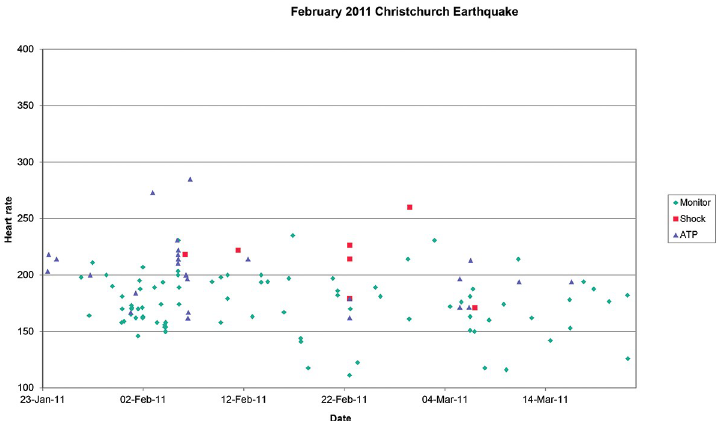
Fig 2. Ventricular arrhythmia events recorded by implantable defibrillators in 236 patients exposed to the earthquake on the 22nd February 2011. Events are plotted against event heart rate. Events are classified as non- sustained (monitor), sustained treated by shock and sustained treated by antitachycardia pacing (ATP).